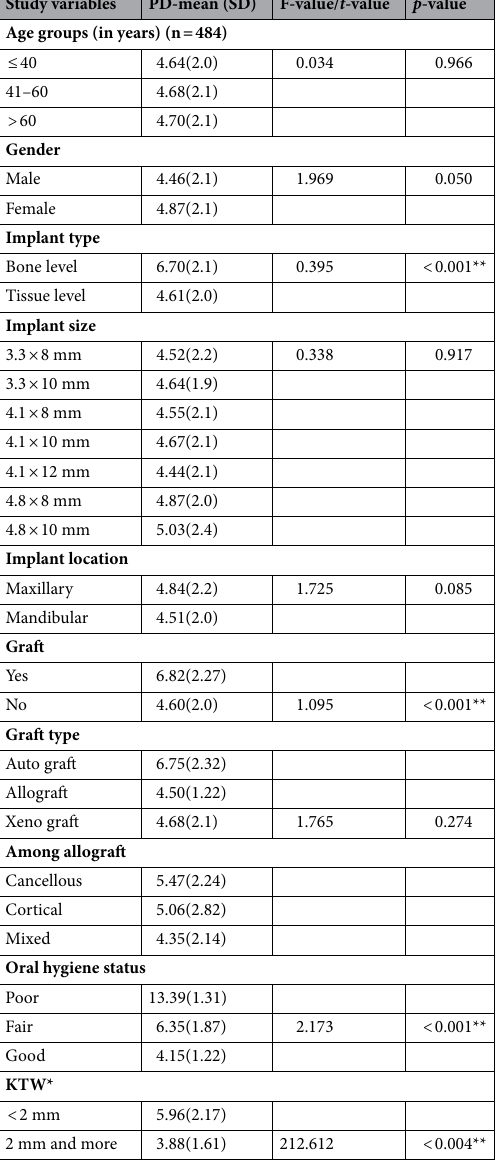
Descriptive statistics (mean, standard deviation, frequencies and percentages) were used to describe the quan- titative outcome variable (PPD, KTW), categorical outcome variables including (PI), (BOP), oral hygiene, Gin- gival color, consistency, and radiographic bone loss and other categorical study variables (age groups, gender, implant type, implant size, implant location, graft vs. none graft as well as graft type). In addition, oral hygiene status and KTW were evaluated. Student’s t-test for independent samples and one-way analysis of variance were used to compare the mean values of PPD in relation to the categorical study variables. Pearson’s Chi-square test